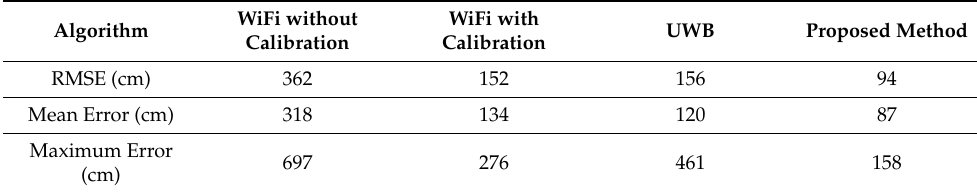
Table 3. Estimated position errors with respect to each